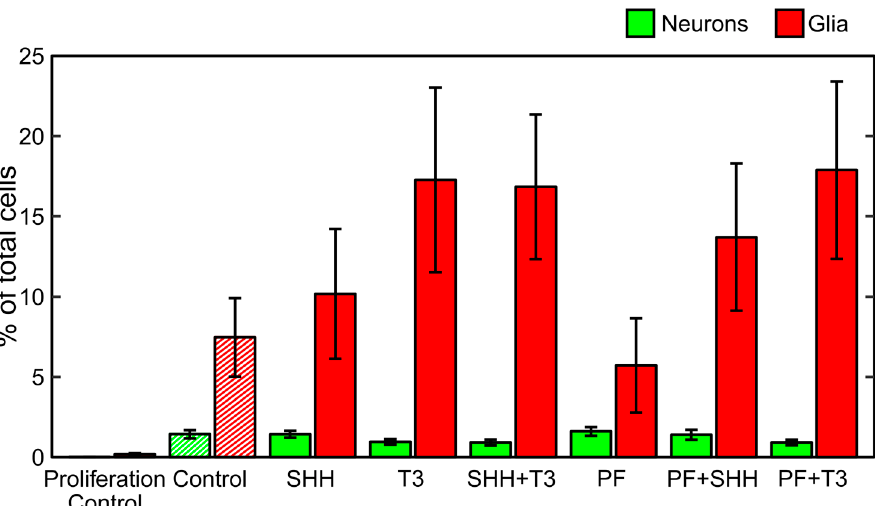
Figure 2. Differentiation analysis. Fraction of neurons and glia determined as neuronal (TUBB3-) and glial (GFAP-)positive cells detected on the last day of the differentiation phase of the experiment (DIV 18). The data represents an average from six experiments and the error bars represent ± SEM.